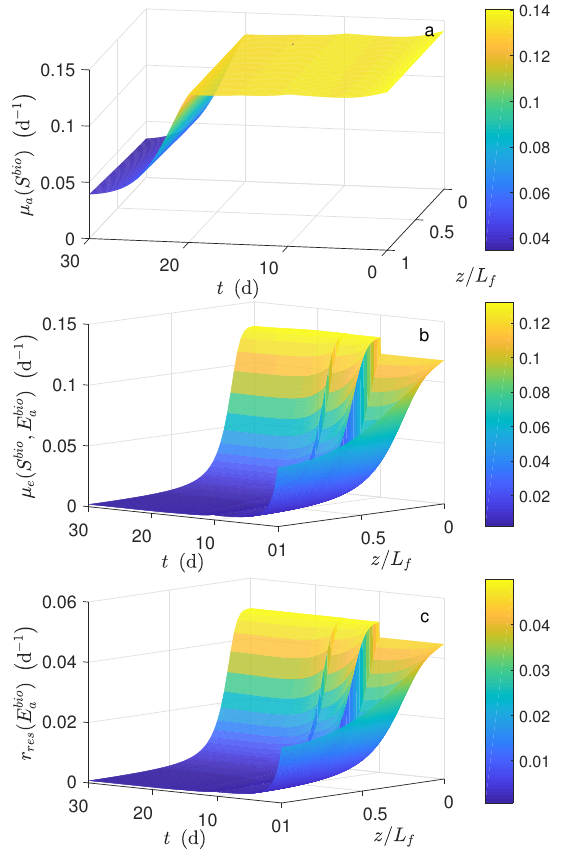
Figure 2. Numerical solution for the MEC model during chronoamperometry operation. Local reaction rate profile ( a ) µ a ( S bio ) , ( b ) µ e ( S bio , E bio a ) and ( c ) r res ( E bio a )